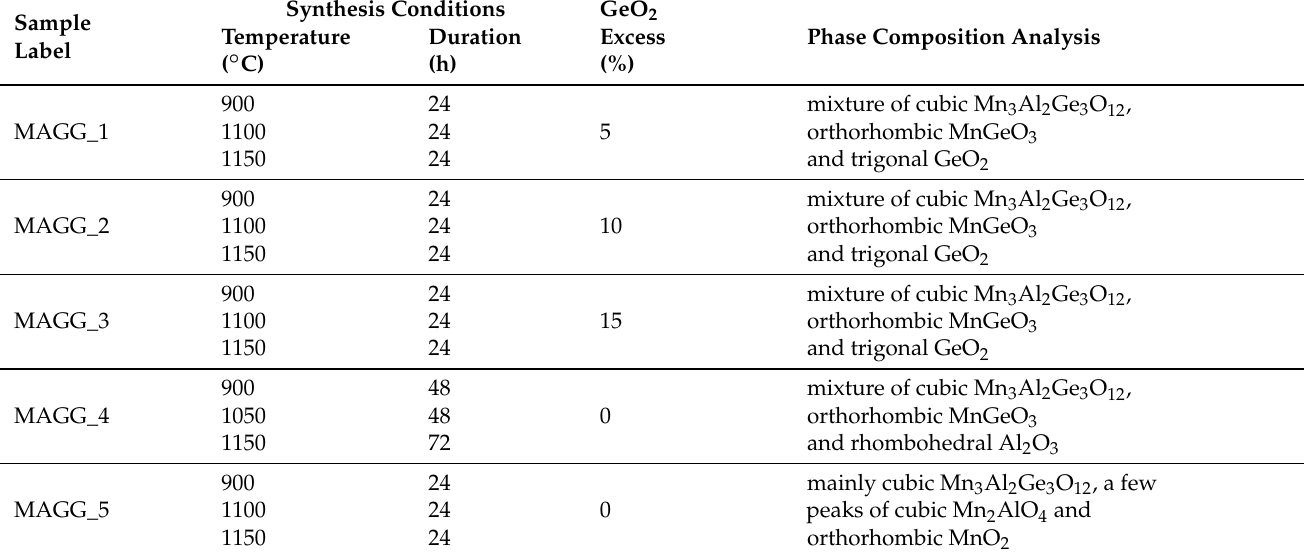
Table 1. Summary of the conditions used for the preparation of the Mn 3 Al 2 Ge 3 O 12 polycrystalline samples. All the samples were sintered in nitrogen gas atmosphere. The results of the phase composition analysis by powder X-ray diffraction are given for each